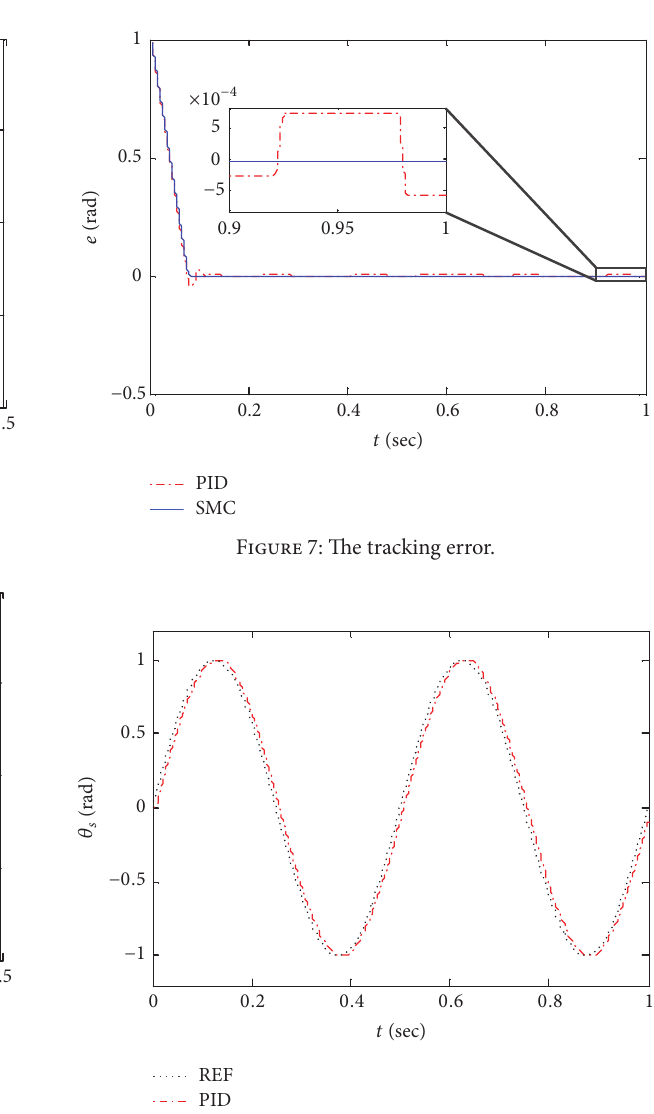
Figure 8: The tracking trajectory under